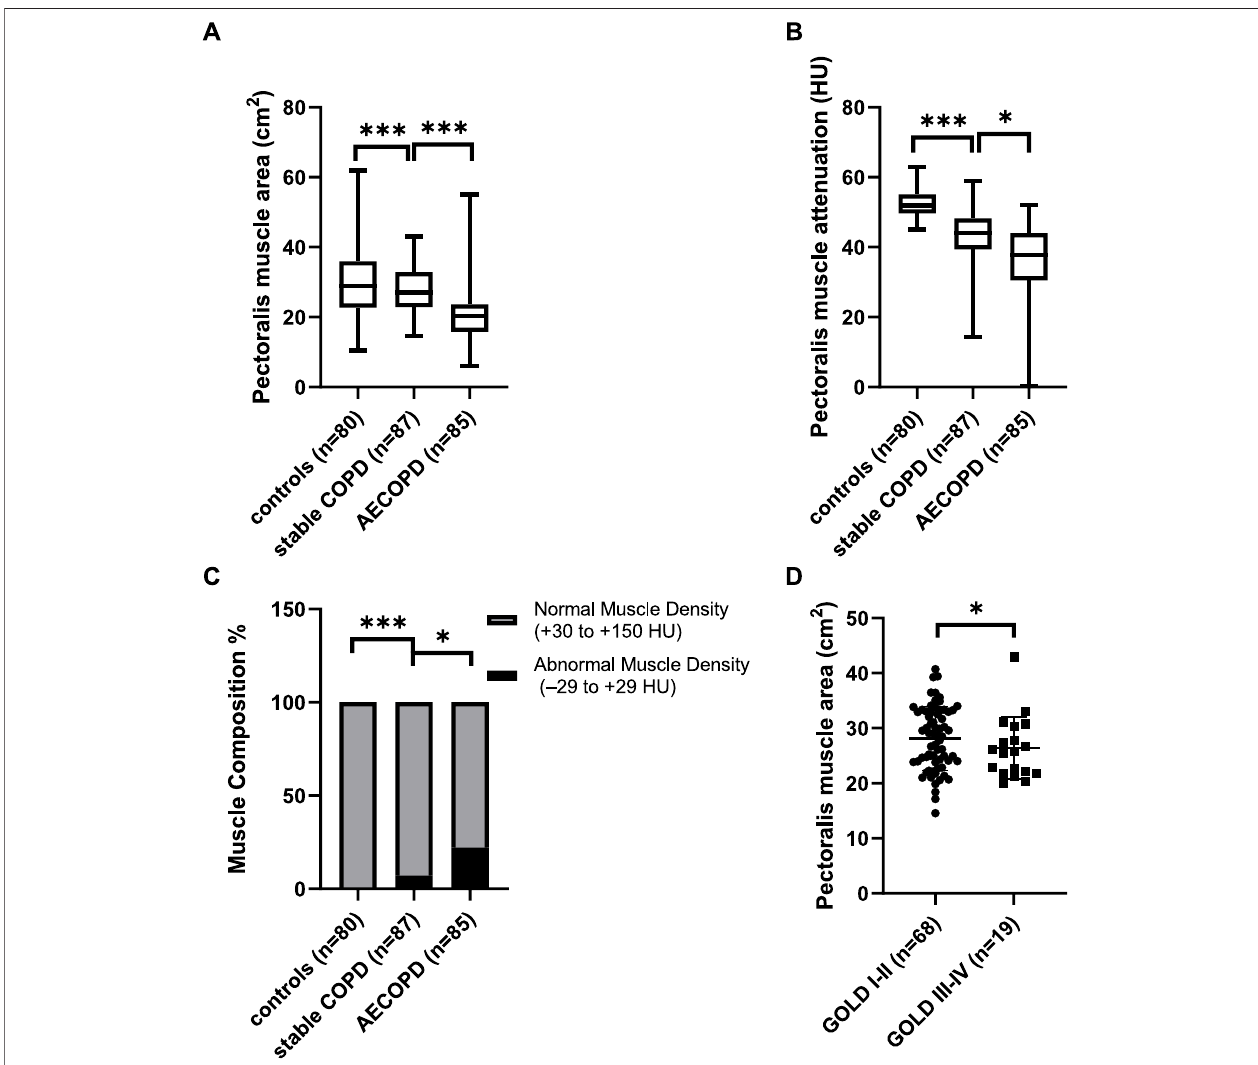
FIGURE 3 | The differences of the pectoralis muscle cross-sectional area (PMA), pectoralis muscle attenuation (PMT), and abnormal muscle proportion between the patients with chronic obstructive pulmonary disease (COPD) and healthy controls. (A) Difference in PMA between the patients with COPD and healthy controls adjusting for age, sex, and body-mass index (BMI), (B) difference in PMT between the patients with COPD and healthy controls adjusting for age, sex, and BMI; (C) difference in the proportion of subjects with abnormal muscle ( − 29 HU ≤ PMT ≤ +29 HU) between patients with COPD and healthy controls; (D) difference in PMA between the patients with global initiative for chronic obstructive lung disease (GOLD) I-II and patients with GOLD III-IV adjusting for age, sex, and BMI. * p < 0.05; *** p < 0.001. AE, acute exacerbation; HU, Houns fi eld unit.